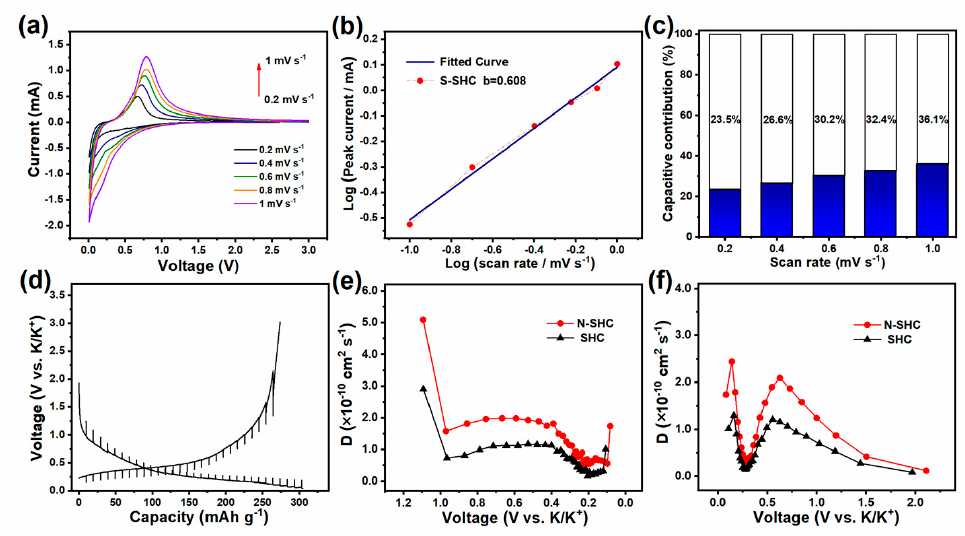
Figure 3. ( a ) CV curves of N-SHC at scan rates from 0.2 to 1 mV s − 1 , corresponding ( b ) relationship between log (peak current) versus log (scan rate) and ( c ) calculated normalized percentages of capacitive capacities’ contributions at various scan rates. ( d ) GITT profiles and diffusion coefficients in ( e ) discharge and ( f ) charge